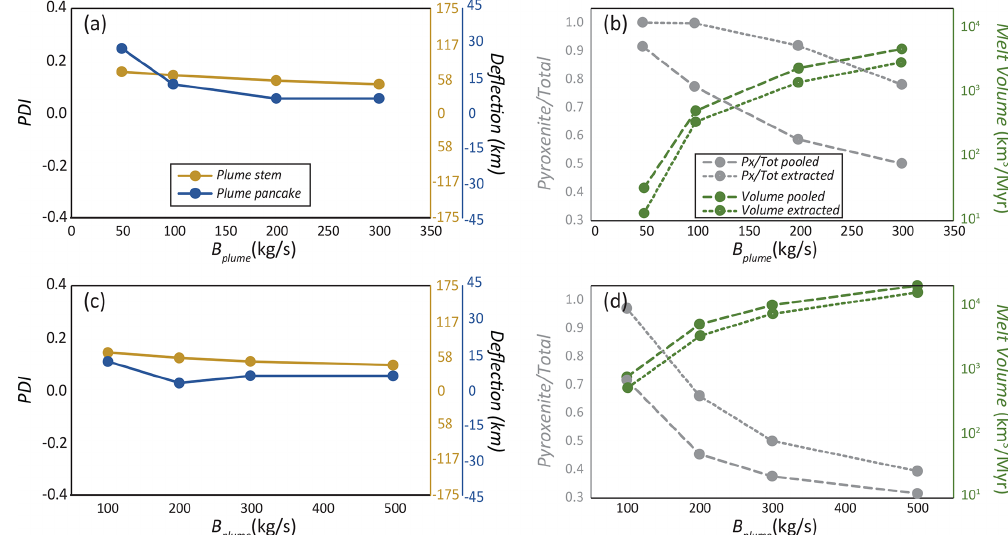
Figure 6. Diagrams showing the variation in key output parameters to changing B plume . (a) PDI stem and PDI pancake for models with variable B plume and (cid:49)T plume = 150 ◦ C. (b) M , V , M PX , and V PX for models with variable B plume and (cid:49)T plume = 150 ◦ C. (c) Same as (a) for models M V with (cid:49)T plume = 200 ◦ C. (d) Same as (b) for models with (cid:49)T plume = 200 ◦ C.